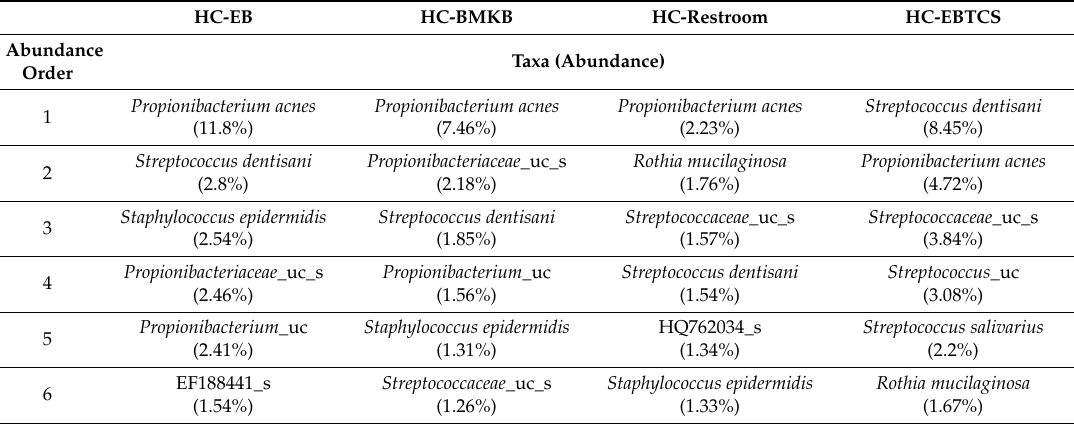
Figure 3. Heat map to compare the bacterial communities between the four samples in terms of Order. Table 2. Identities of the six most abundant OTUs in the bacterial